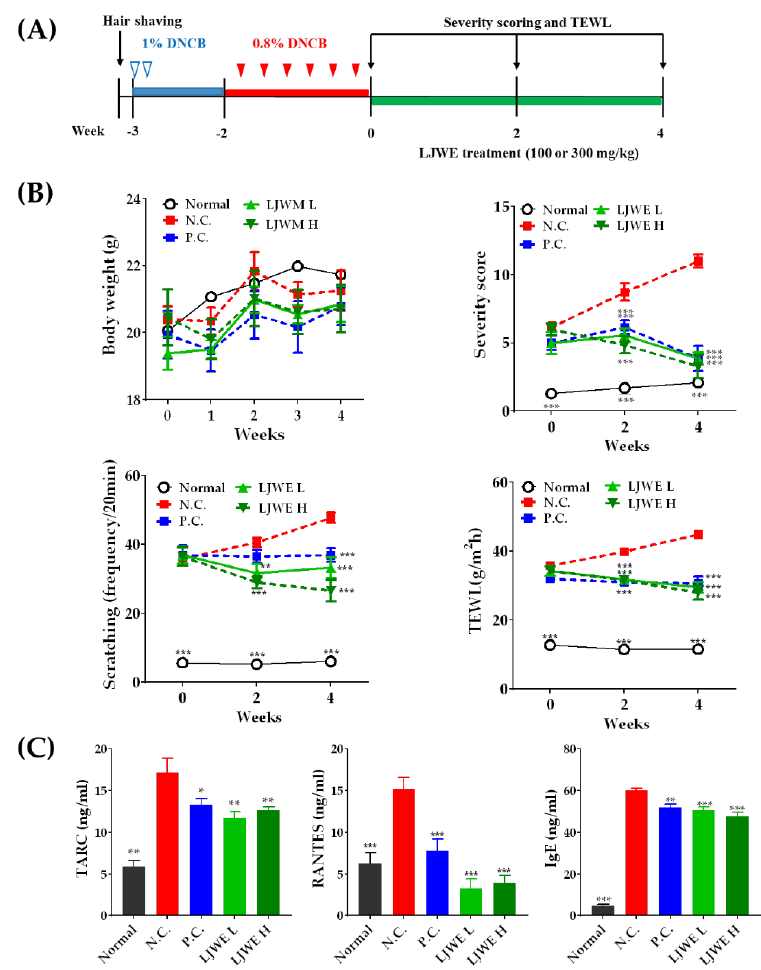
Figure 3. LJWE ameliorates atopic dermatitis (AD)-like skin lesions in NC / Nga mice. ( A ) Schematic representation of the experiment investigating the effect of LJWE on AD-like skin lesions induced by 2,4-dinitrochlorobenzene (DNCB). ( B ) Changes in the body weight, severity score of dermatitis, and trans-epidermal water loss (TEWL) during the experimental periods. ( C ) Inhibitory effects of LJWE on the overproduction of TARC, RANTES and IgE. Normal (no DNCB / vehicle); negative control (N.C., DNCB / vehicle); positive control (P.C., DNCB / 5 mg / kg of prednisolone); low-dose LJWE (LJWE L; DNCB + 100 mg / kg per day of LJWE); high-dose LJWE (LJWE H; DNCB + 300 mg / kg per day of LJWE). All data are expressed as the mean ± standard error of the mean (SEM) ( n = 7). * p < 0.05, ** p < 0.01, *** p < 0.001 versus